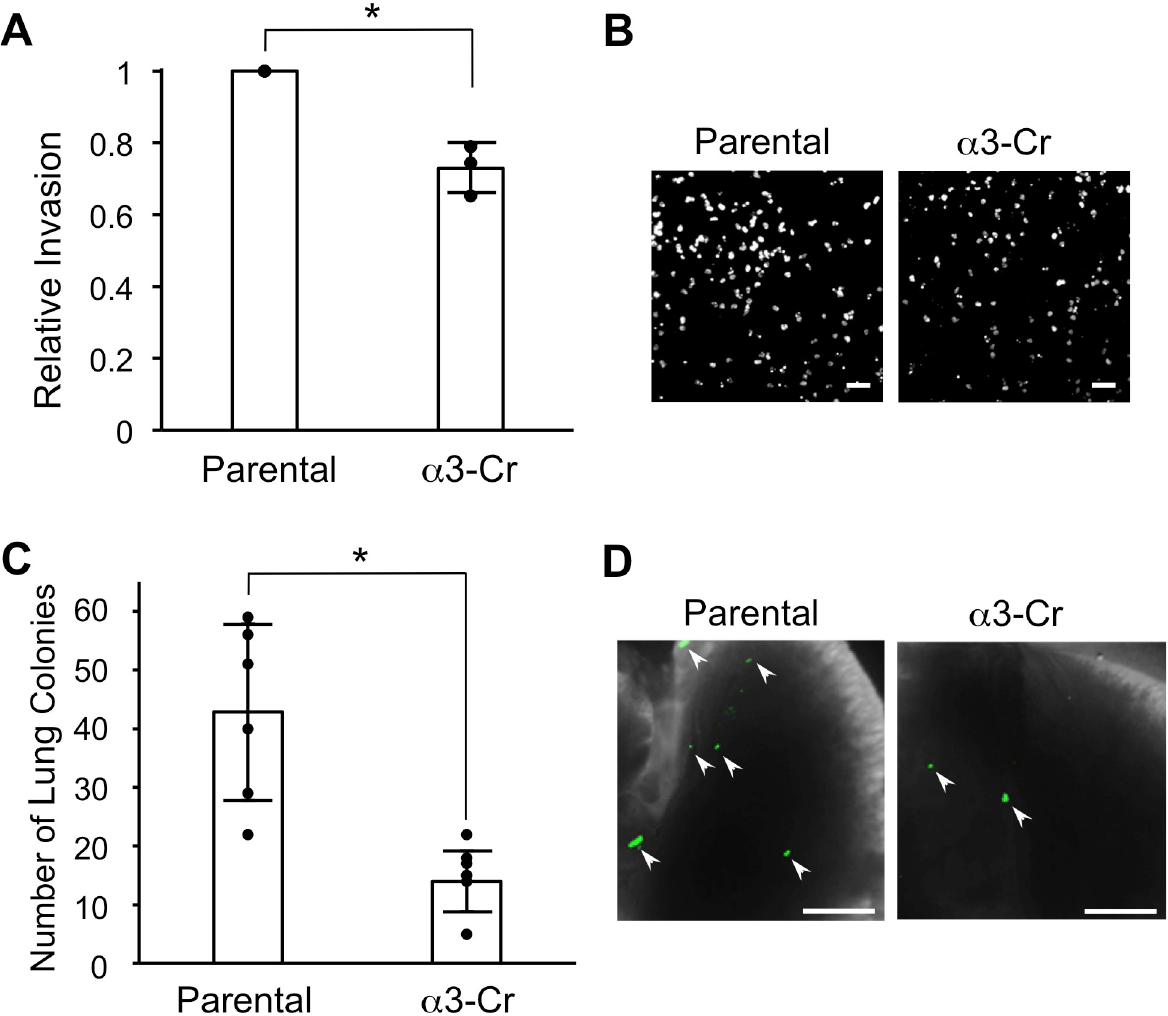
Fig 5. CRISPR-targeting of the ITGA3 gene reduces cell invasion in vitro and metastatic colonization in vivo . Matrigel invasion assays were performed to compare invasion in parental MDA-MB-231 cells and α 3-Cr cells. (A) Graph shows α 3-Cr cell invasion relative to parental. Nuclei were stained with DAPI, imaged and quantified; n = 3; mean +/ − SD; � p < 0.05, unpaired t-test. (B) Images show representative fields of DAPI- stained cells that invaded through transwell filters. Scale bars,100 μ m. (C) Parental MDA-MB-231 cells or α 3-Cr cells were labeled fluorescently by transduction with a lentivirus expressing ZsGreen, then 1 X 10 4 cells were injected into tail-veins of 5-week old, female NSG ™ mice. Graph shows number of lung colonies 21 days post-injection; n = 6 (Parental) or 7 ( α 3-Cr); mean +/- SD; � p < 0.05; two-tailed t-test. (D) Images show portions of lungs at time of harvest. Arrowheads point to examples of colonies detected by green fluorescence. Scale bars, 2 mm.